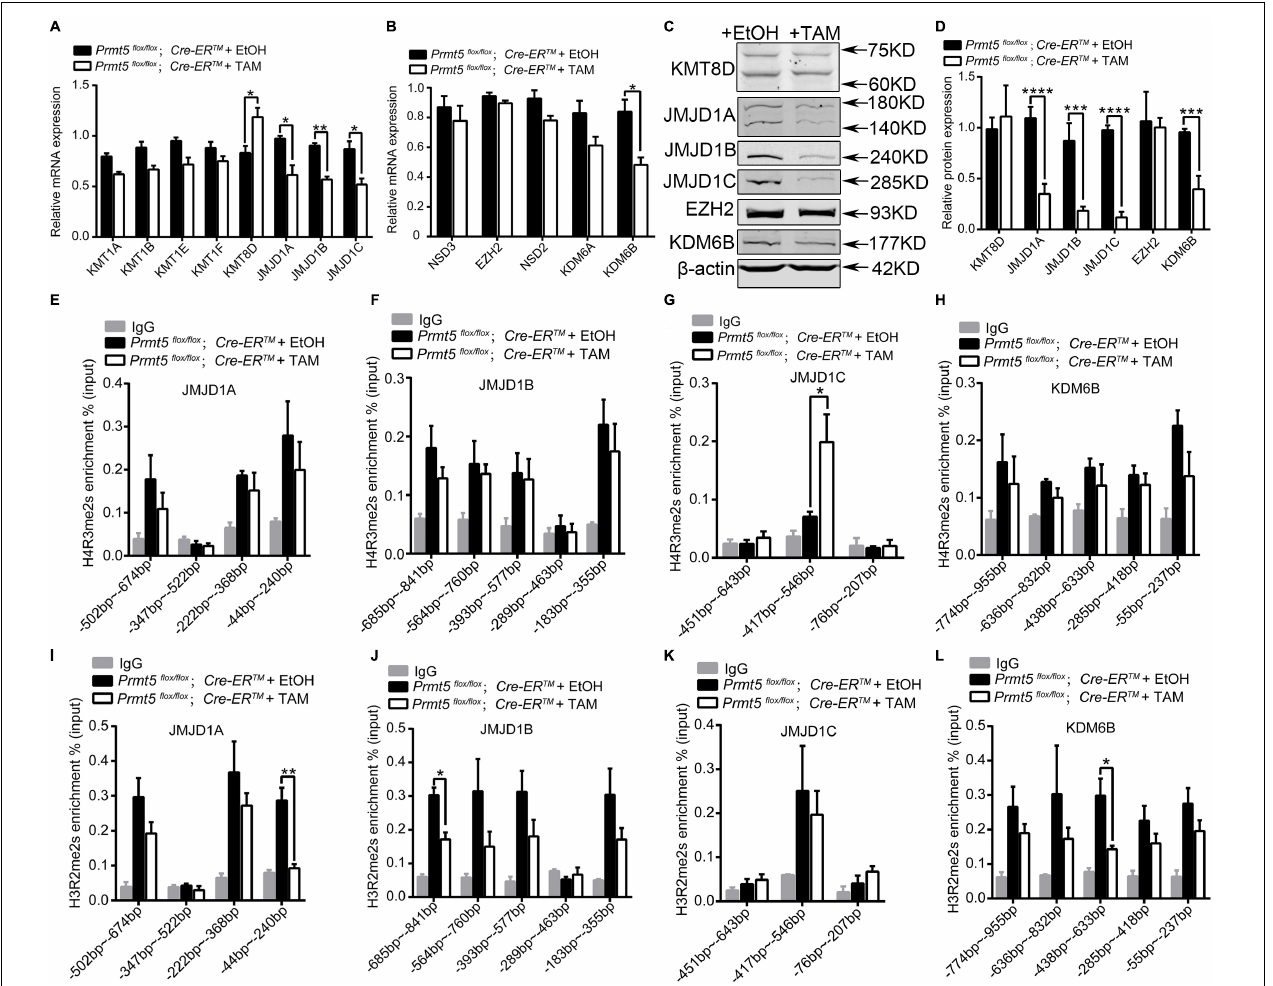
FIGURE 7 | The expression of lysine demethylases of H3K9me2 and H3K27me2 is regulated by PRMT5 via histone arginine modifications. The differential expression of lysine methylases and demethylases of H3K9me2 and H3K27me2 in Prmt5 -deficient SSCs was analyzed by real-time PCR (A,B) and western blot (C,D) . β -Actin was used as a loading control, and the protein values were normalized. ChIP-qPCR assays were performed to examine the enrichment of H4R3me2s or H3R2me2s modifications at the upstream regions of JMJD1A (E,I) , JMJD1B (F,J) , JMJD1C (G,K) , and KDM6B (H,L) in Prmt5 -deficient SSCs. The immunoprecipitated DNA fragments were analyzed by real-time PCR with sequence-specific primer sets. IgG was used as a negative control. Quantitative data are presented as the enrichment of the ChIP to the input DNA. Error bars represent the SEM of triplicate results. * P < 0.05, ** P < 0.005, *** P < 0.0005, **** P < 0.00005 indicates a significant difference ( t